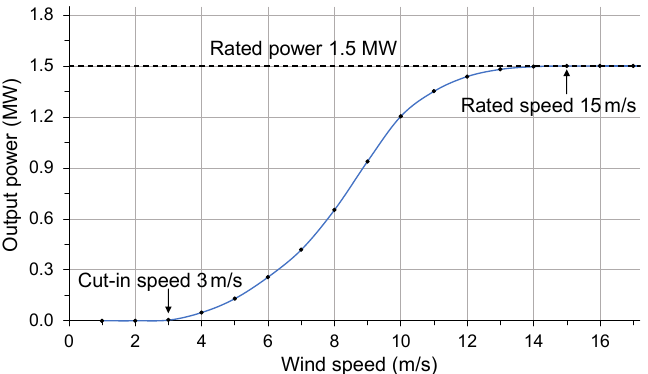
Figure 7. Required section of the guaranteed power curve (blue line) of the General Electric GE 1.5sl, which is given by the discrete values (black dots on the blue line) taken from the turbine database of The Wind Power [15].